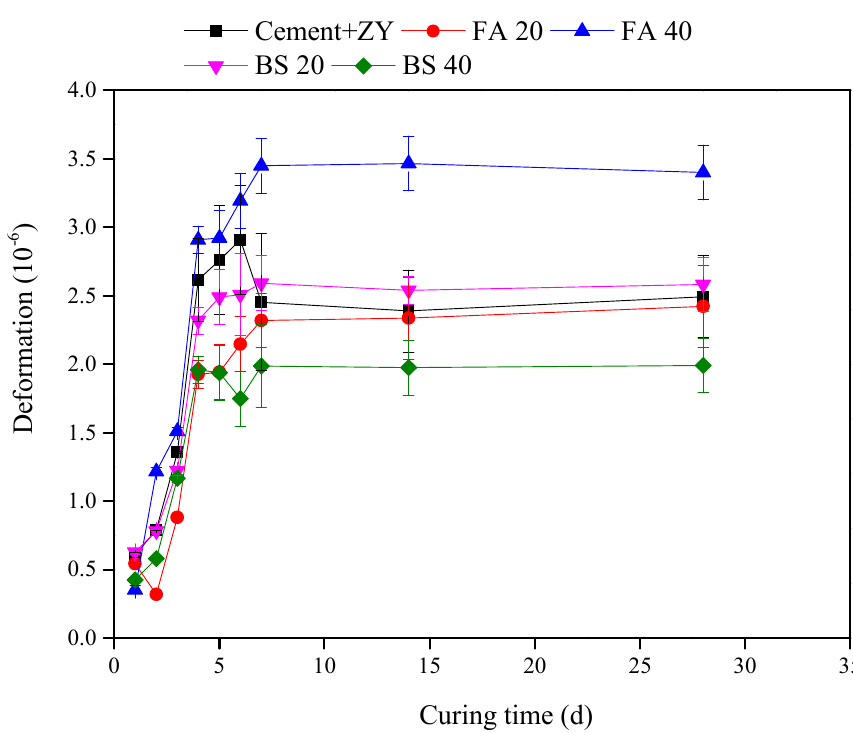
Figure 3. Free expansion rate of mortars cured in water at 293 K.